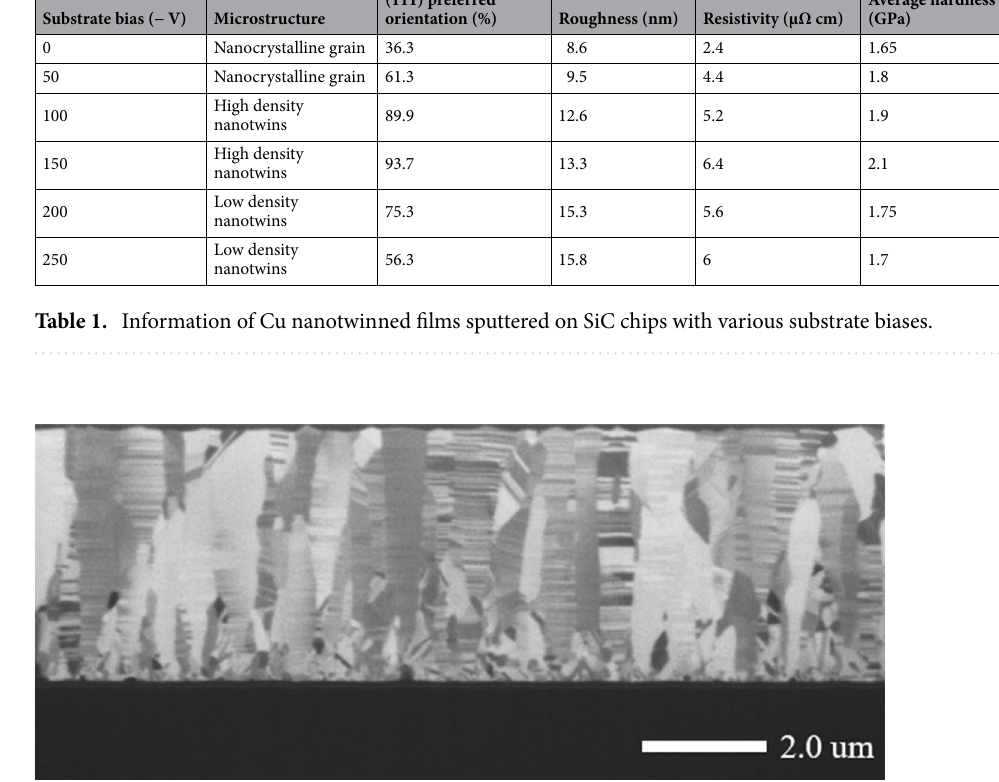
Figure 10. The FIB cross-sectional metallographs of the sputtered Cu films deposited with substrate bias of − 150 V on Si